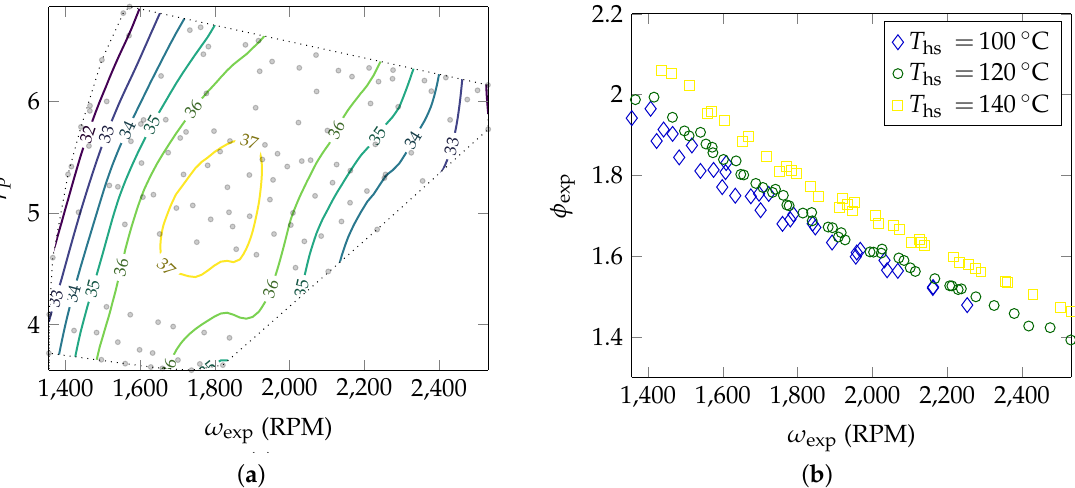
Figure 7. (a) Expander isentropic efficiency, η exp,is expressed in %, mapped against the scroll spindle speed, ω exp , and the pressure ratio, r P . Performance map obtained from cubic-spline interpolation of experimental data, indicated as grey dots on the map, obtained for heat-source temperatures ranging from 100 to 140 ◦ C. (b) Expander filling factor as a function of the expander spindle speed.